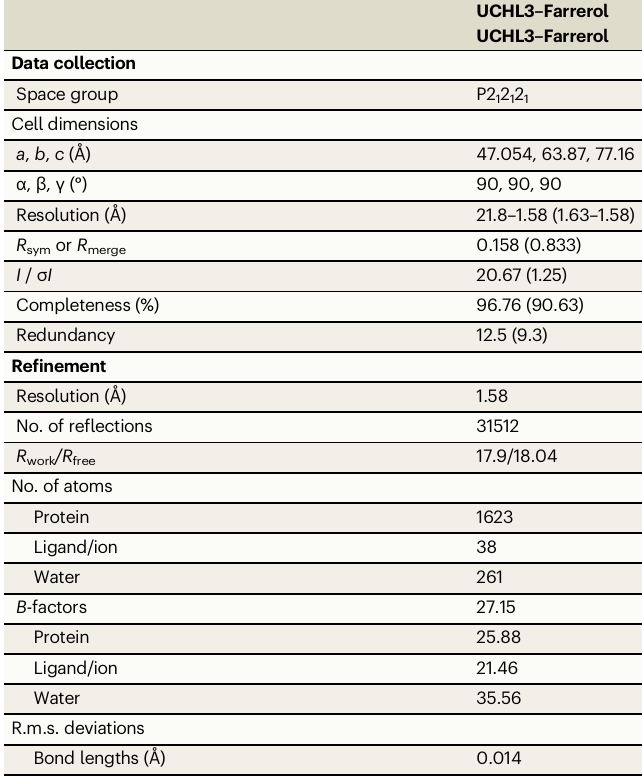
Table 1 | Data collection and re fi nement statistics (molecular